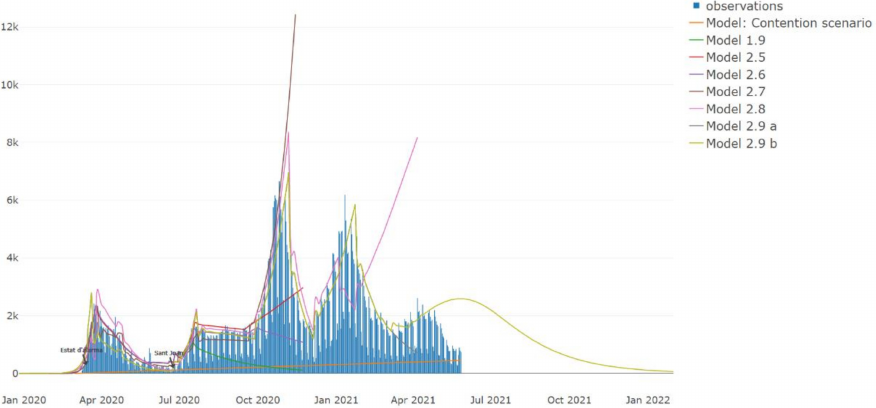
Figure 10. The different models that we develop due to the continuous validation process, new cases ( y